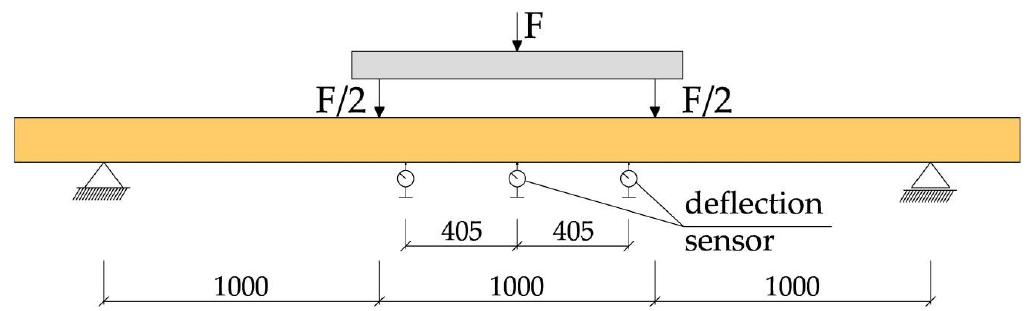
Figure 2. Test stand [dimensions in mm].